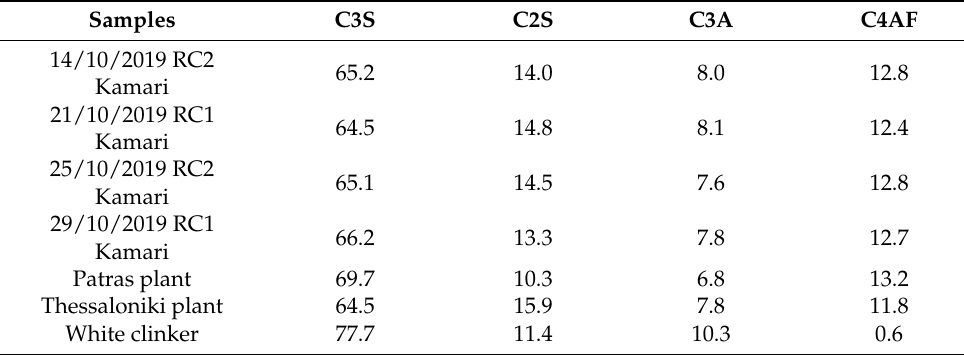
Table 3. Bogue normative compositions of the cement